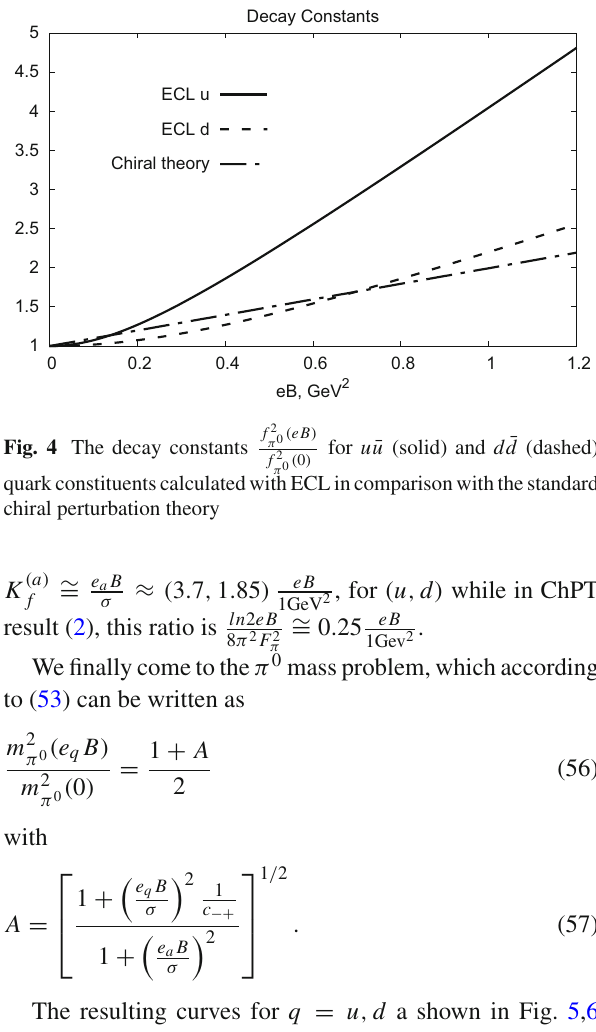
m 2 π 0 ( eB ) Fig. 6 The pion mass ratio with d ¯ d quark constituents cal- e 2 π 0 ( 0 ) culated with ECL (solid line) in comparison with the lattice data from [31,32] (dots) and with the standard chiral perturbation theory predic- tion from